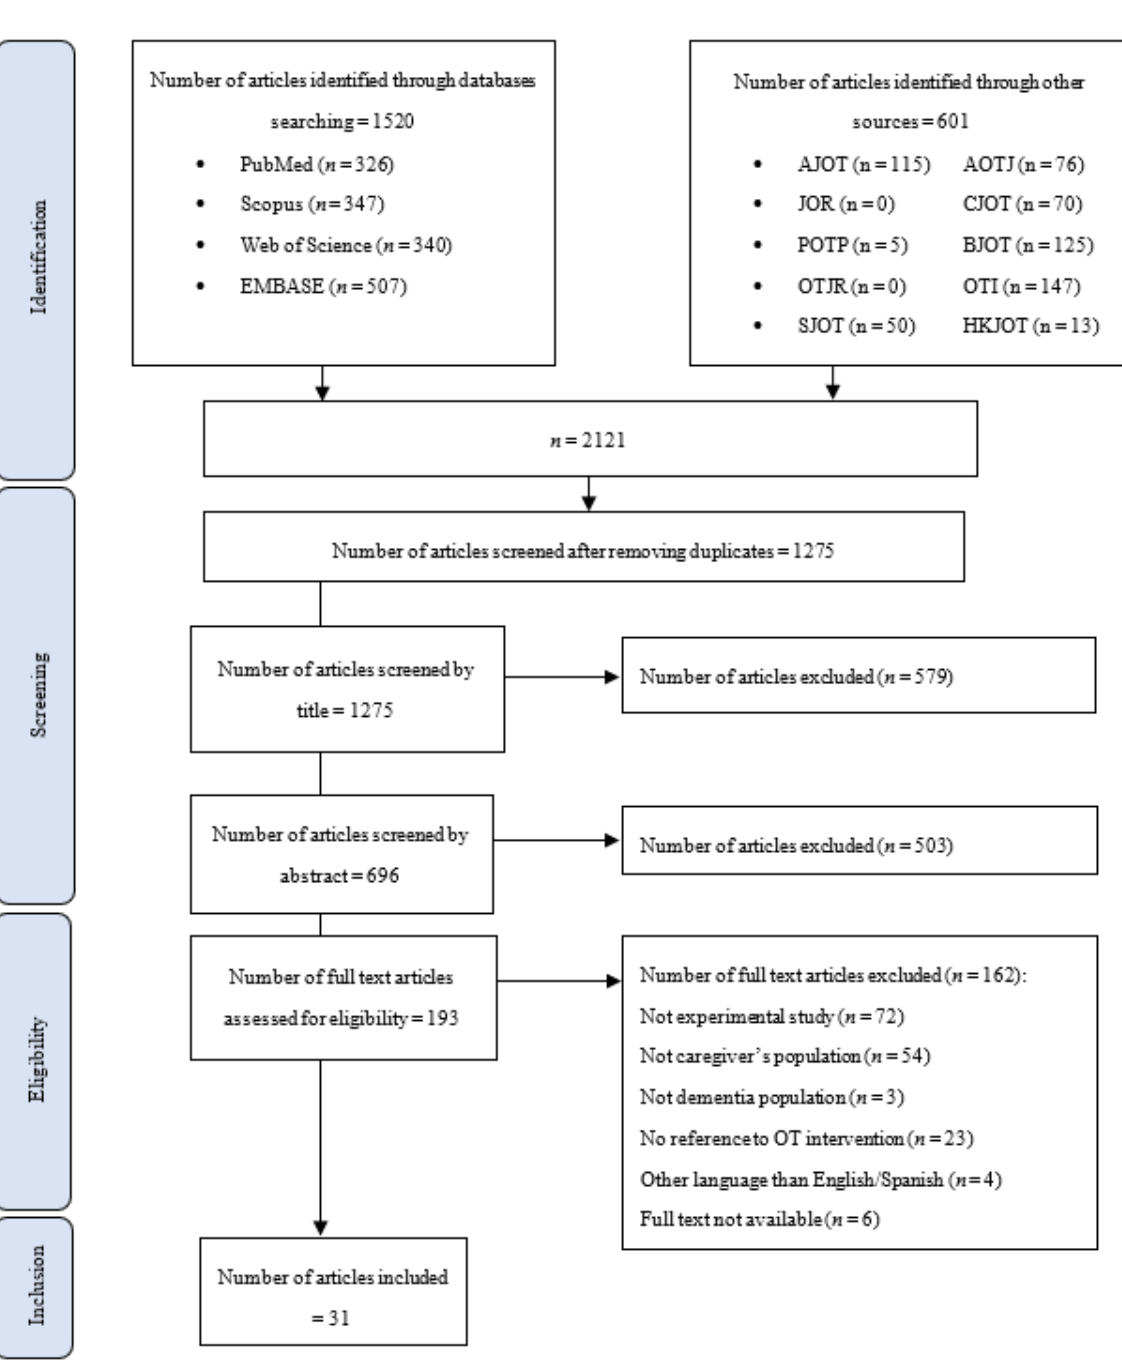
Figure 1. Flowchart of the study selection. AJOT, American Journal of Occupational Therapy; AOTJ, Australian Occupational Therapy Journal; BJOT, British Journal of Occupational Therapy; CJOT, Canadian Journal of Occupational Therapy; JOR, Journal of Occupation Rehabilitation; HKJOT, Hong Kong Journal of Occupational Therapy; OTI, Occupational Therapy International; OTJR, Occupation, Participation, and Health; POPT, Physical and Occupation Therapy in Pediatrics; SJOT, Scandinavian Journal of Occupational Therapy.